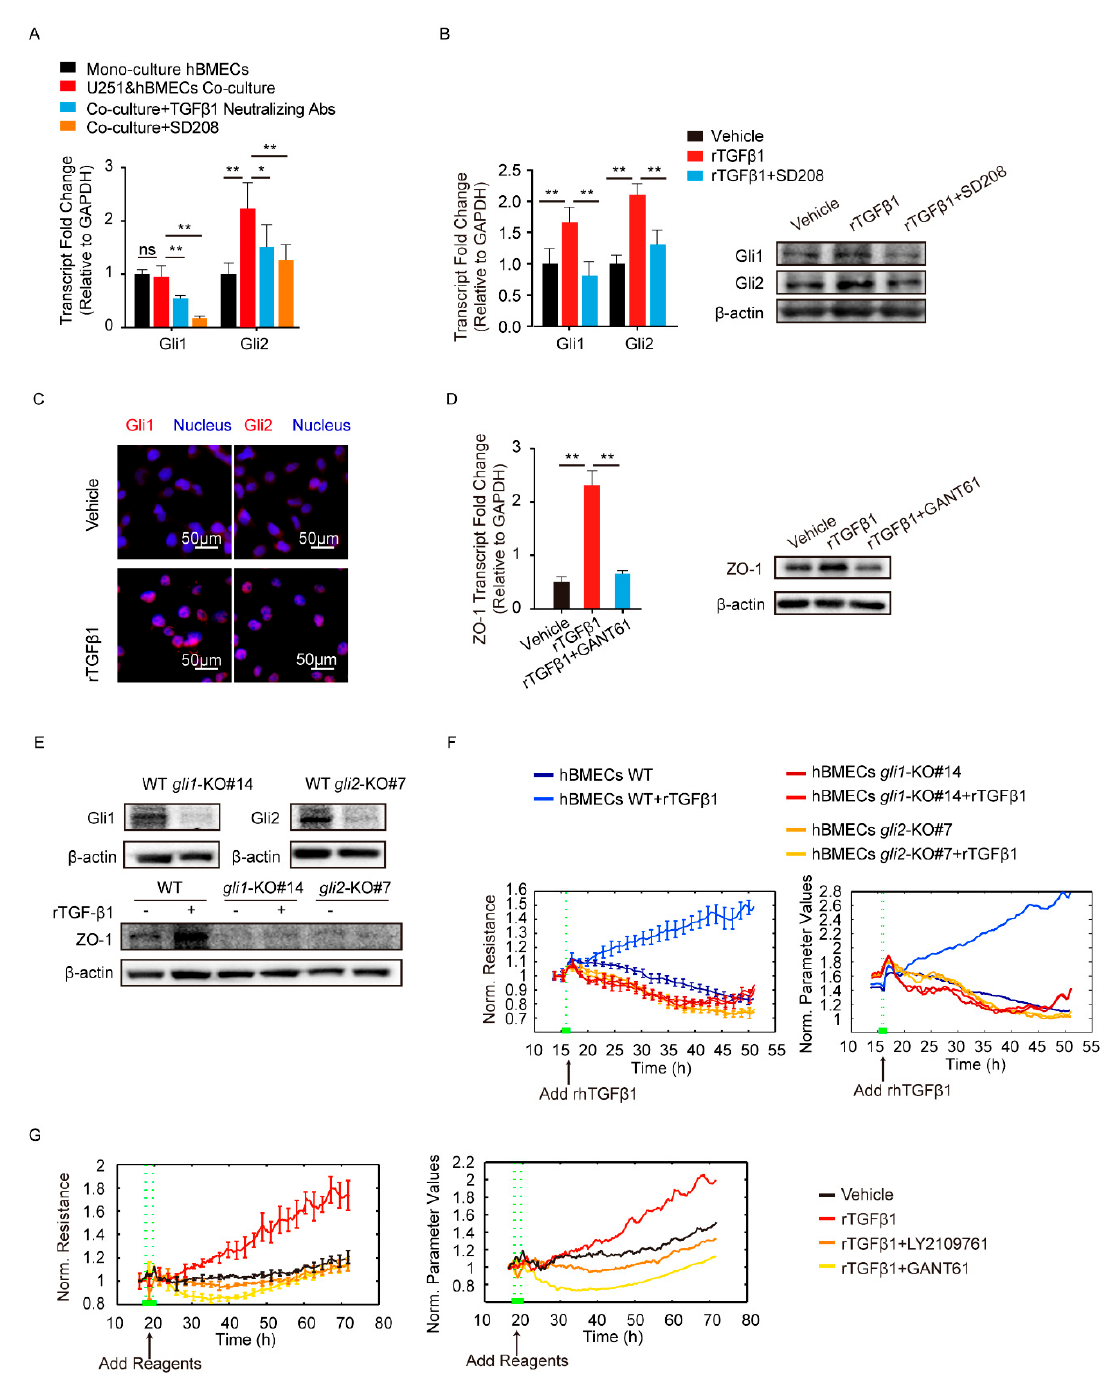
Figure 4. TGF β 1 enhanced ZO-1 expression via non-canonical hedgehog signaling. ( A ) The transcription of Gli1 and Gli2 in mono-culture hBMECs and the co-culture of hBMECs with or without TGF β 1 neutralizing antibody (10 µ g/mL) or SD208 (10 µ M). * p < 0.05 and ** p < 0.01. ( B ) The expression of Gli1 and Gli2 in response to rTGF β 1 (50 ng/mL) with or without SD208 (10 µ M) pretreatment via Western blot and qPCR. ** p < 0.01. ( C ) Nucleus translocation of Gli1 and Gli2 in hBMECs in response to TGF β 1 (50 ng/mL) via IF. Scale indicates 50 µ m. ( D ) The expression of ZO-1 in hBMECs in response to TGF β 1 (50 ng/mL) with or without GANT61 (10 µ M) via Western blot and qPCR. ** p < 0.01. ( E ) The gli1 and gli2 deletion in hBMECs through CRISPR/Cas9, and the expression of ZO-1 in both WT cells and KO cells in response to TGF β 1. ( F ) ECIS assays analyzing the barrier resistance of the WT cells and the gli1 or gli2 KO cells with the addition of TGF β 1 (50 ng/mL). ( G ) ECIS assays showing the effects of TGF β 1 (50 ng/mL), together with LY2109761 (10 µ M) or GANT61 (10 µ M), on the barrier function of monolayer hBMECs.